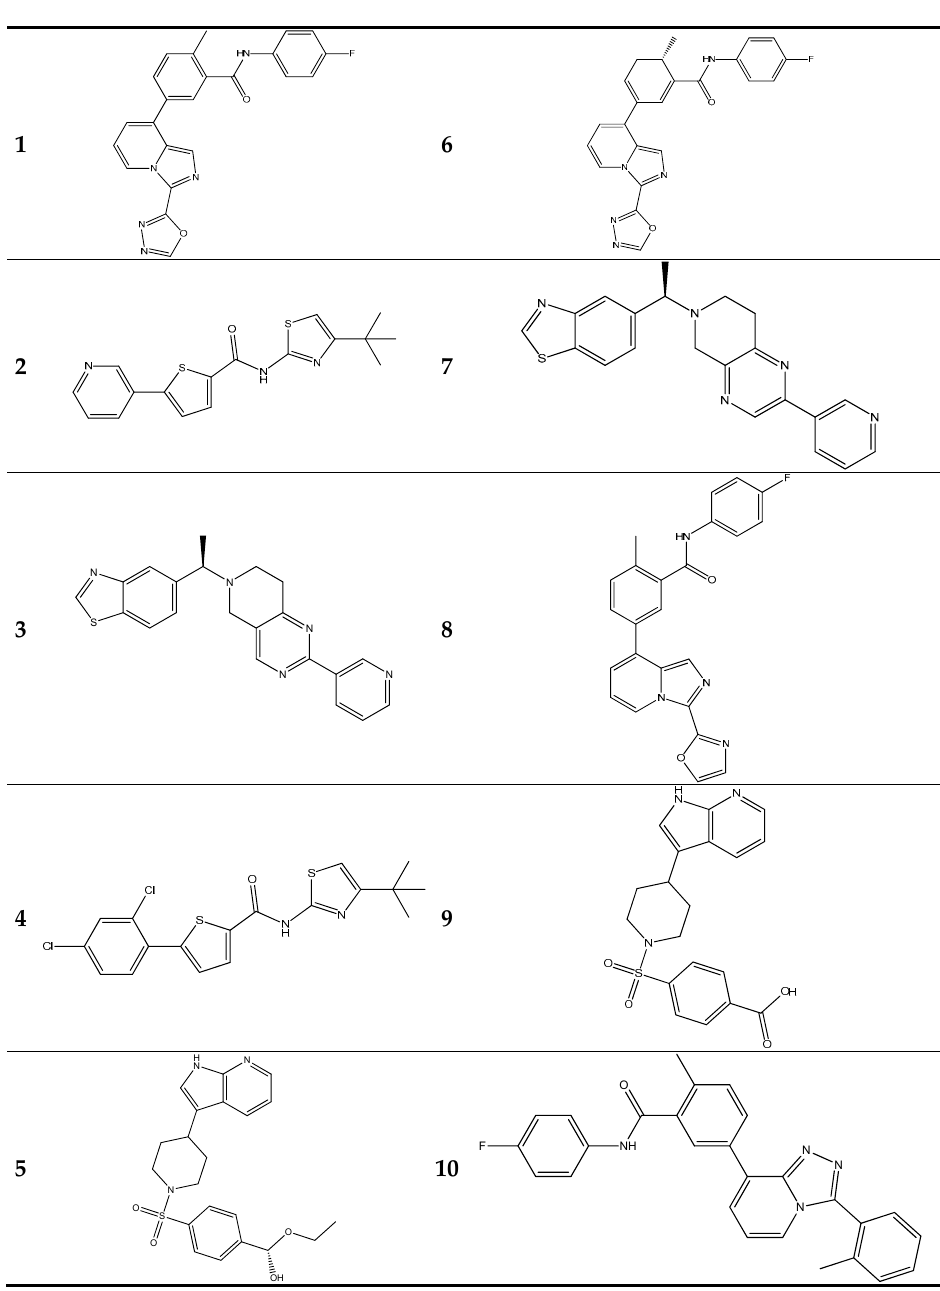
Figure 2. Virtual screening results for pharmacophore hypothesis A1P2R3R4R5R6R7. (numbered from 1 to 10).